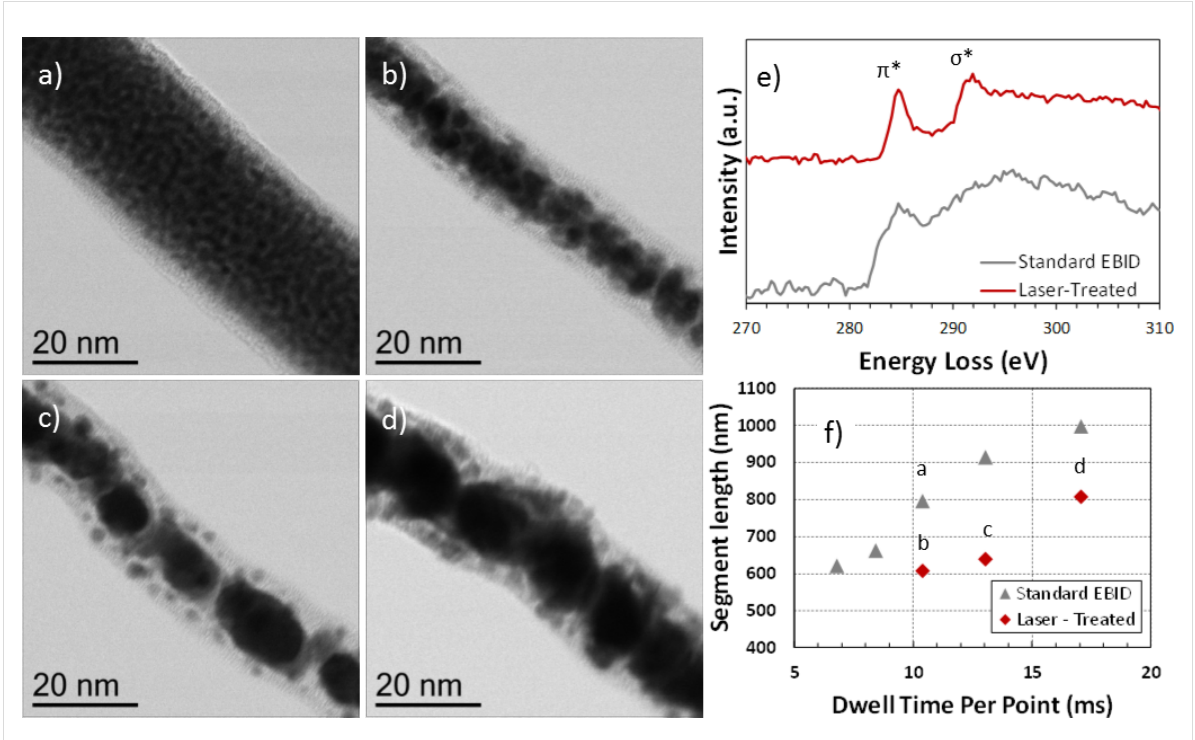
Figure 3: BF STEM images of a) an as-deposited EBID segment with a 10.4 ms dwell time per pixel and in situ LAEBID performed at various dwell times per point including b) 10.4 ms, c) 13.0 ms and d) 17.0 ms. e) EELS spectra obtained from as-deposited and laser-treated segments grown with a dwell time of 17 ms per point. f) Plot of segment length as a function of dwell time for both standard EBID segments and laser-treated EBID seg- ments. The alphabetic labels highlight the points corresponding to the BF STEM images in parts a)–d).